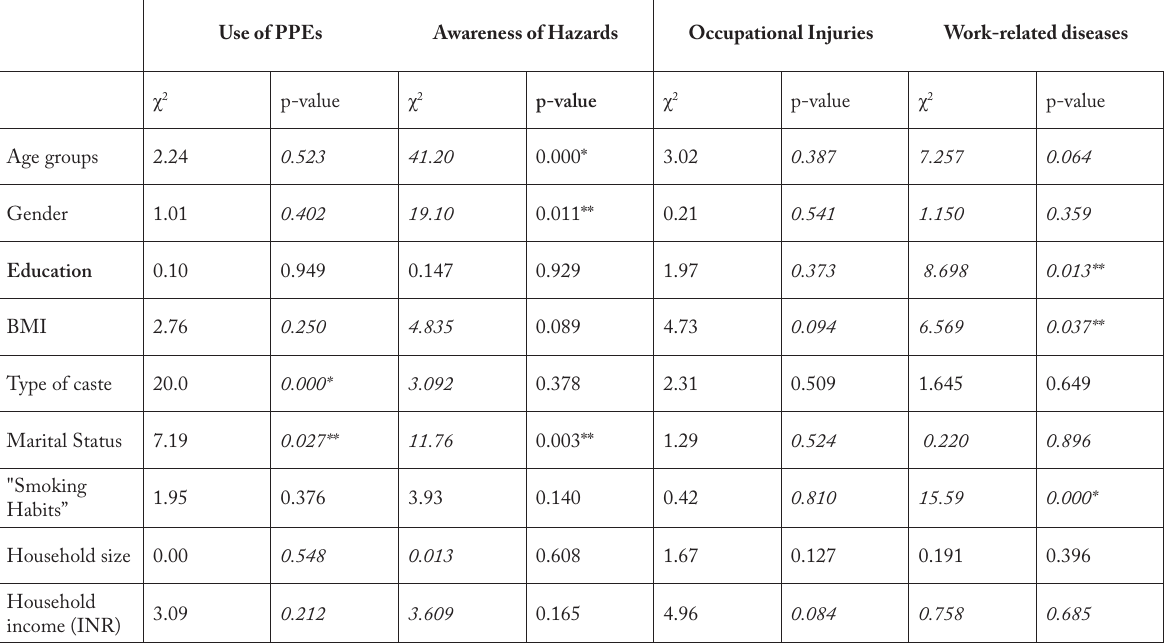
Table 3. Use of PPEs, awareness of workplace hazards, occupational injuries and work-related diseases among mine workers from block ‘Karauli’, Karauli district, Rajasthan, India ( n =